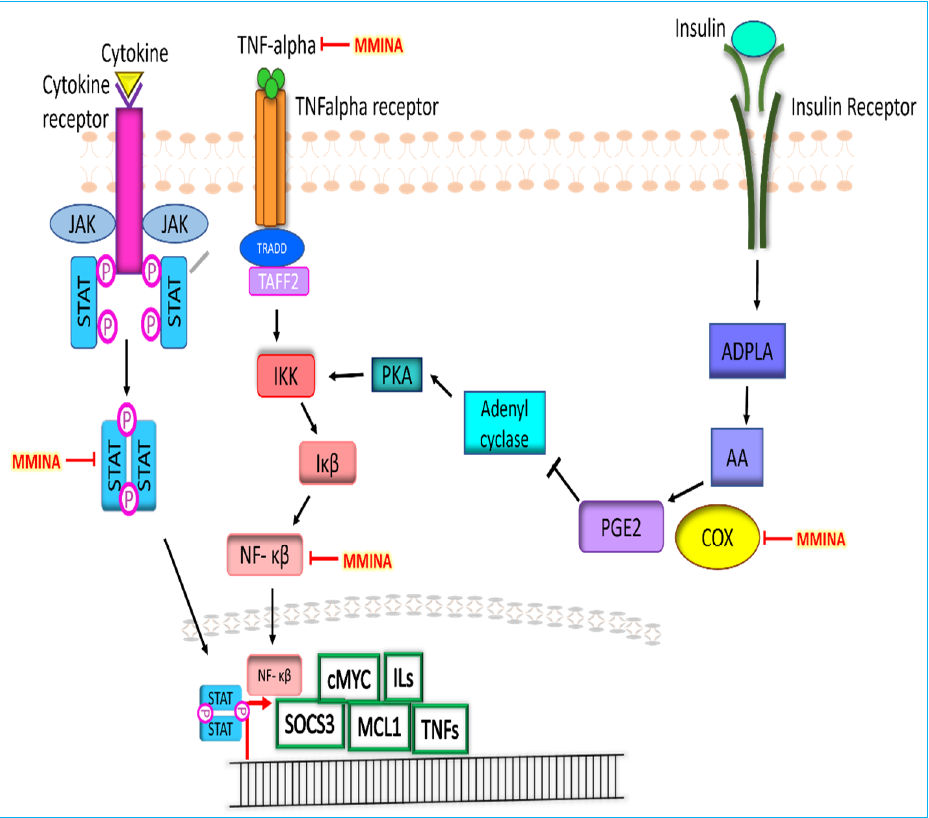
Figure 7. Proposed pathways of MMINA effect on the signal transduction of inflammatory biomarkers. Cytokine/JAK-STAT signaling and TNFalpha/NF-κβ signaling mainly contribute to the manifestation of inflammation. MMINA downregulates the expression of NF-κβ, TNFalpha, and STAT3 at mRNA and protein levels and reduces inflammation. COX2 pathway crosstalk also activates the NF-κβ signaling and contributes to inflammation. MMINA also regulates COX2 expression and inhibits this pathway.